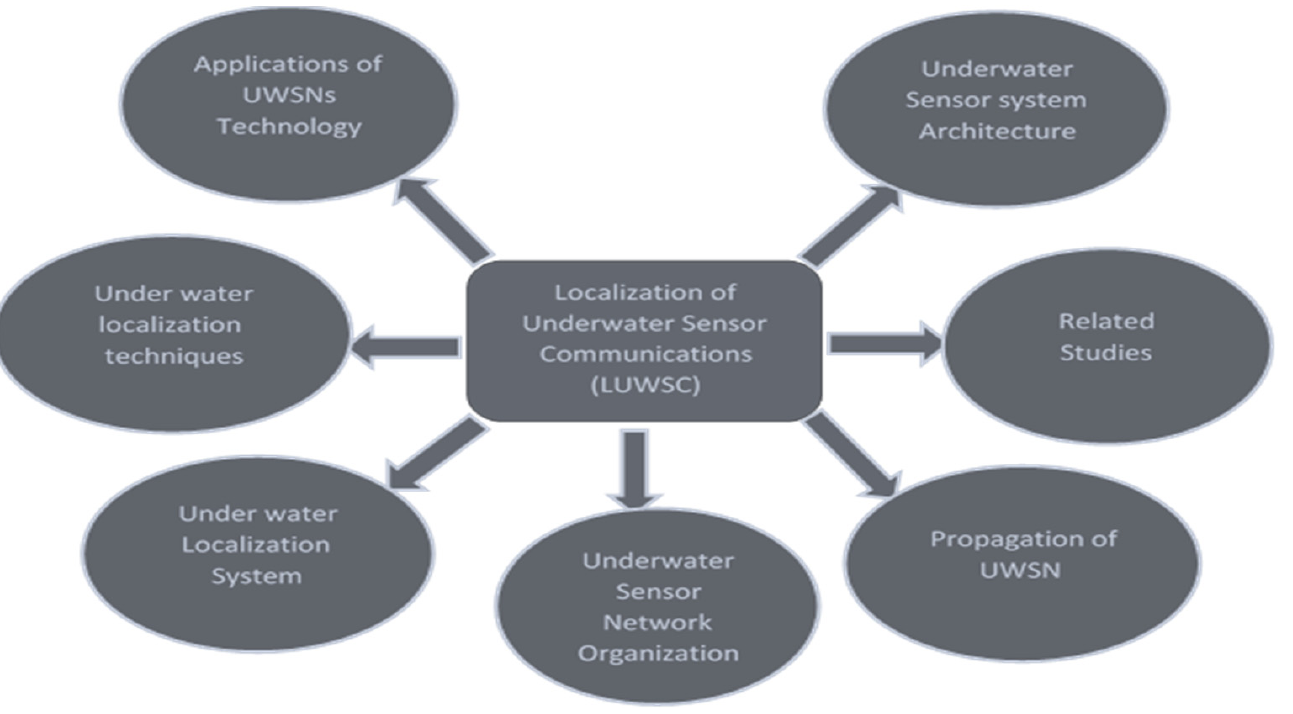
Figure 1. Organization of the paper.